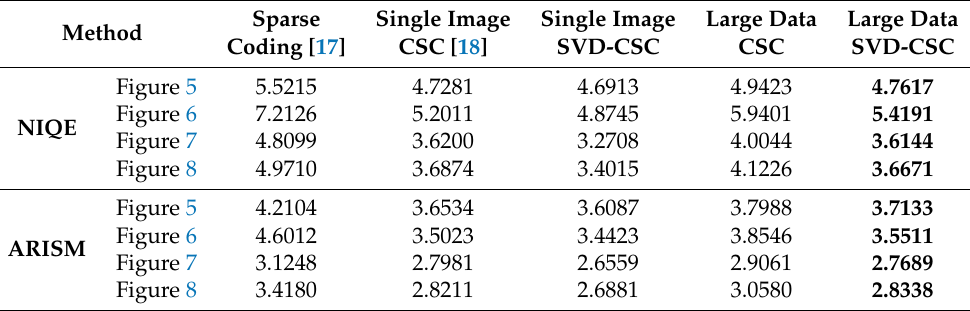
Table 1. Objective evaluation for Retinex algorithm (11 × 11 × 100 filters).